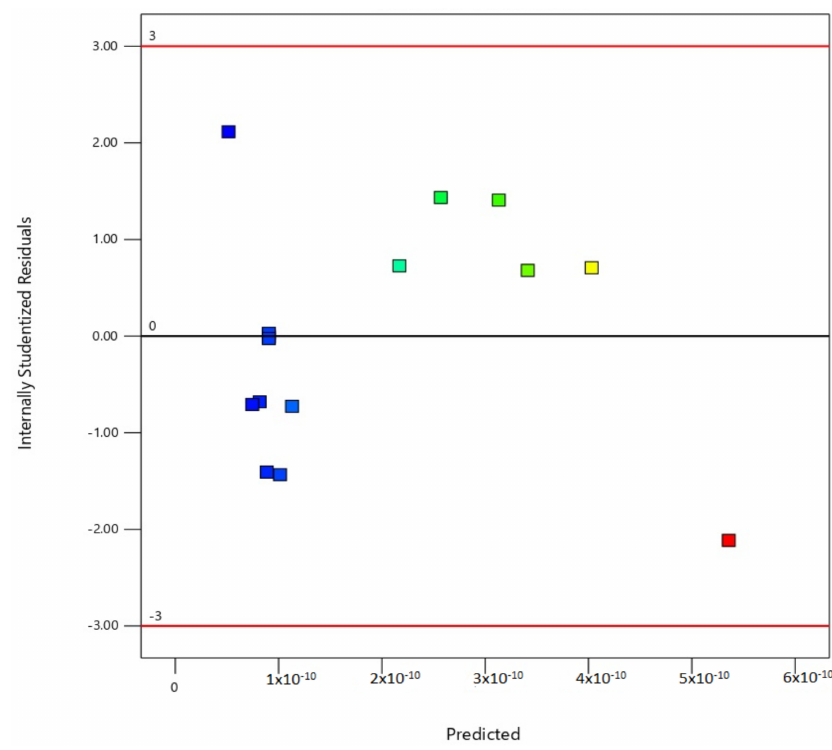
Figure 5. Plot of studentized residuals vs. predicted